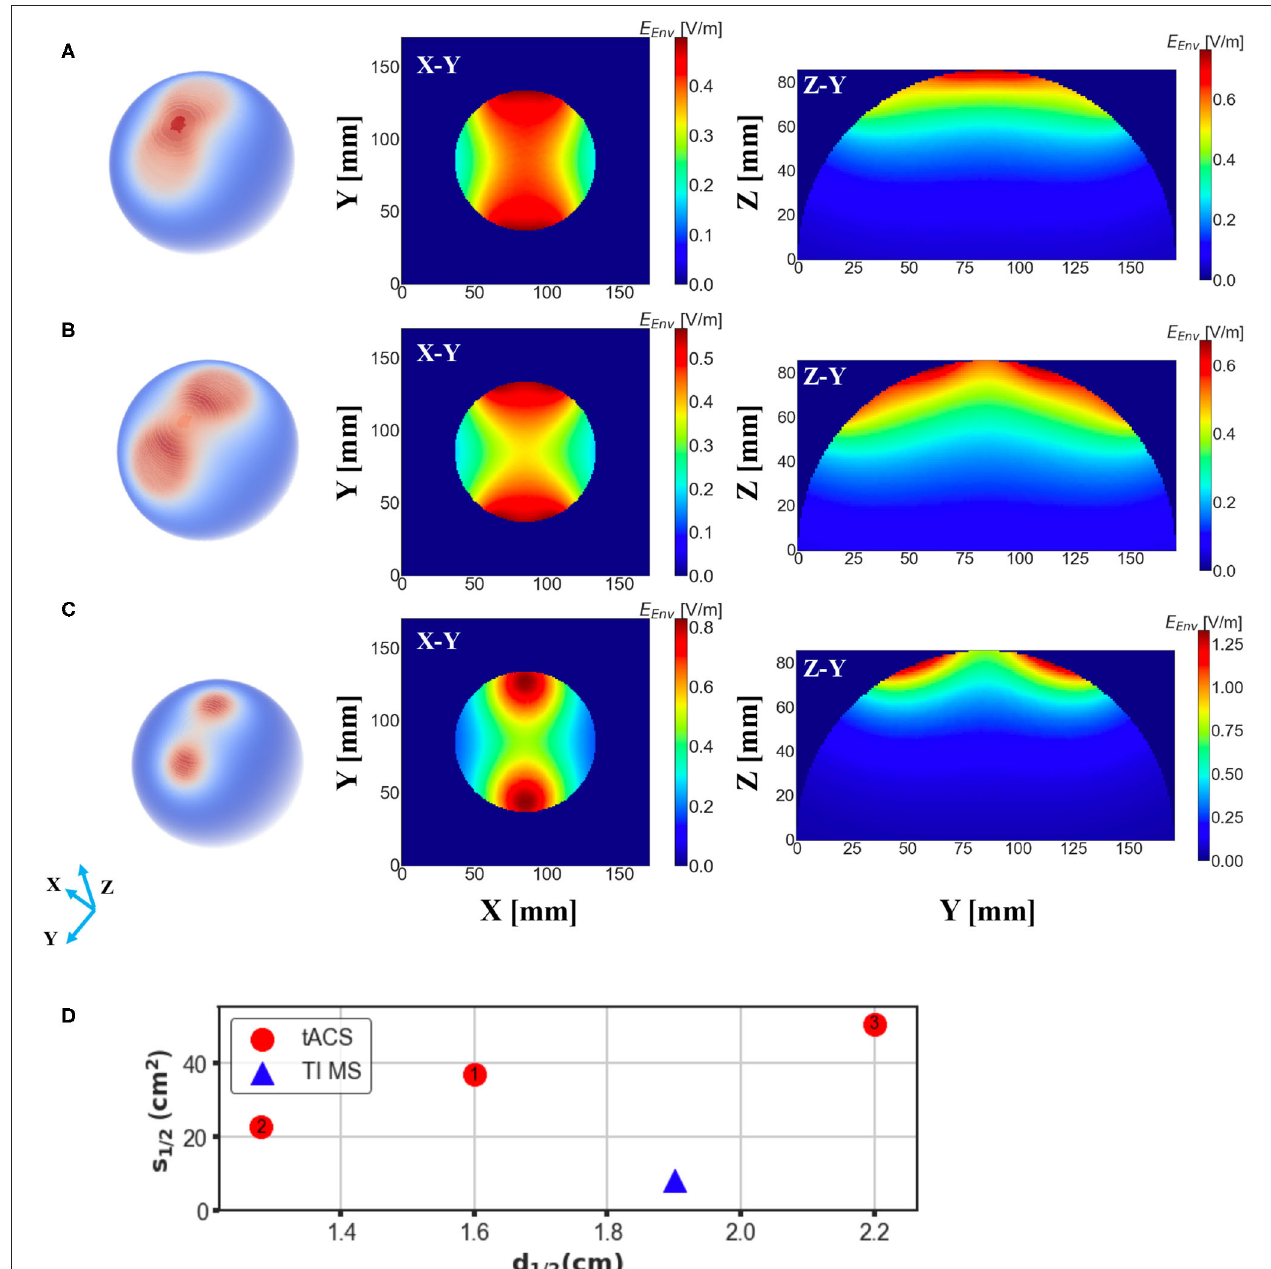
FIGURE 6 | Electric field distribution in the head model induced by a conventional tACS scheme with distinct electrode montages. E-field spread on the surface of the brain is shown in the first column and cross-sections of the model (brain part) from different direction axes are displayed in the last two columns. (A) Two electrodes with a radius of 2.8 cm were placed symmetrically on the surface of the head with an interval of 45 degree to the center. (B) The same setup as (A) but the angular separation was changed to 60 degree. (C) The same setup as (A) but the radius of the electrodes was changed to 1.4 cm. (D) Depth-focality performance of the tACS in comparison with the suggested TI magnetic stimulation scheme (ED 20 mm). TI magnetic stimulation exhibits better performance for a focal and relatively deep stimulation.